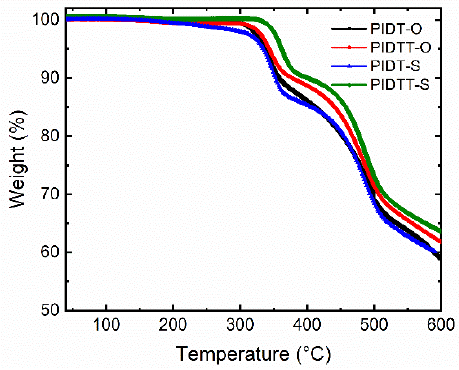
Figure 1. Thermal gravimetric analysis curves of PIDT-O, PIDTT-O, PIDT-S and PIDTT-S.